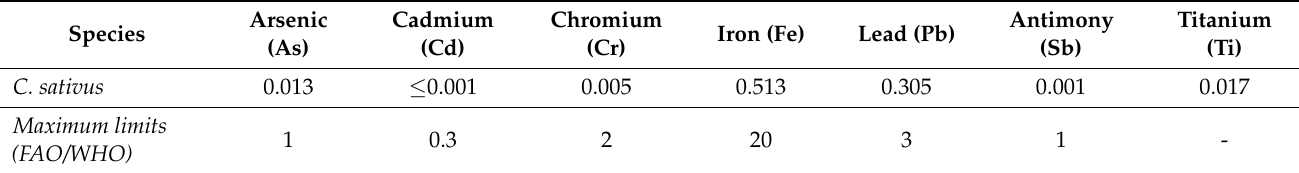
Table 5. Heavy metal concentration (mg/L) and maximum limits FAO/WHO